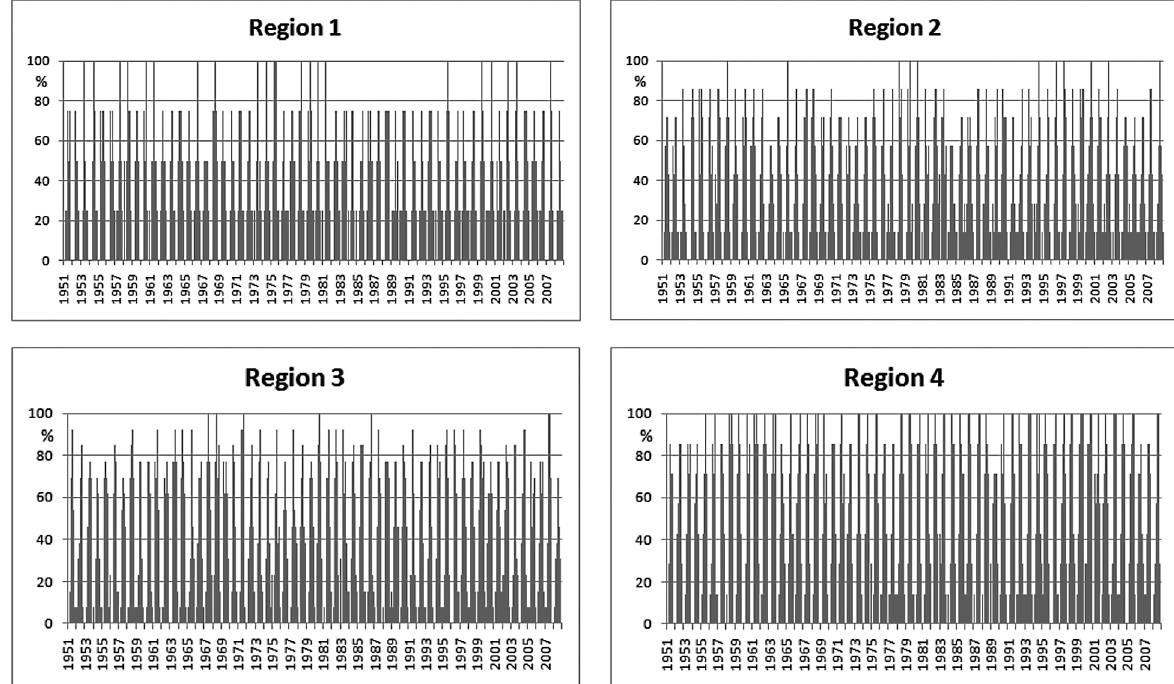
Fig. 6. The frequency of the simultaneous occurrence of days with thunderstorms in all stations in a given